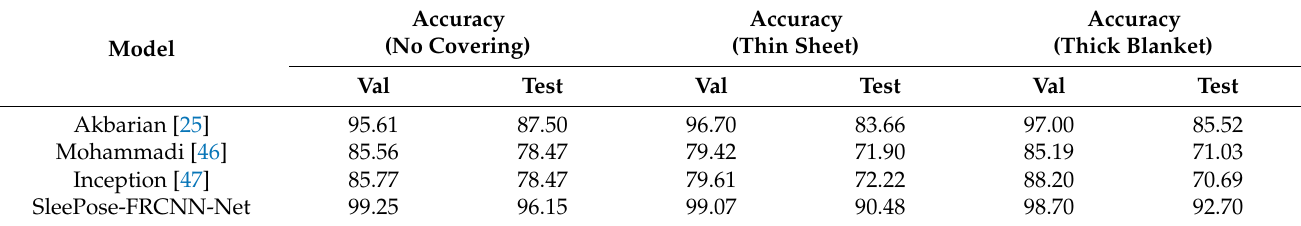
Table 8. Results of head pose classification on the SLP dataset.